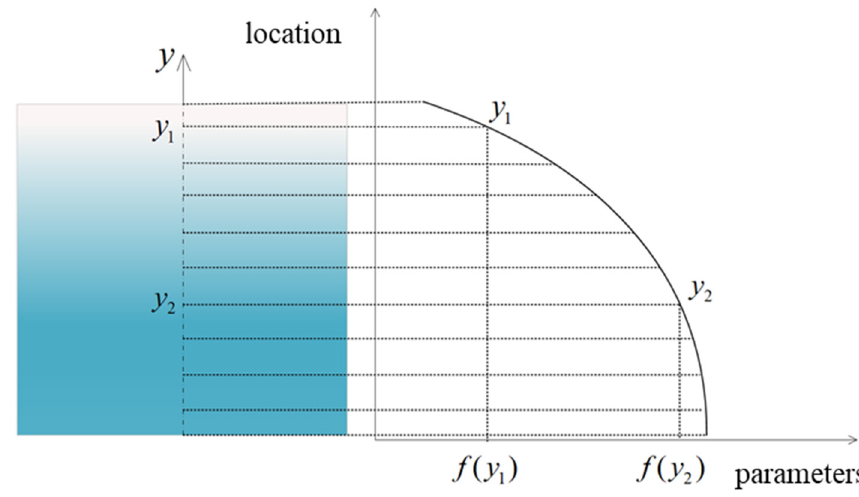
Figure 5. FGM material distribution characteristics and parameter changes.